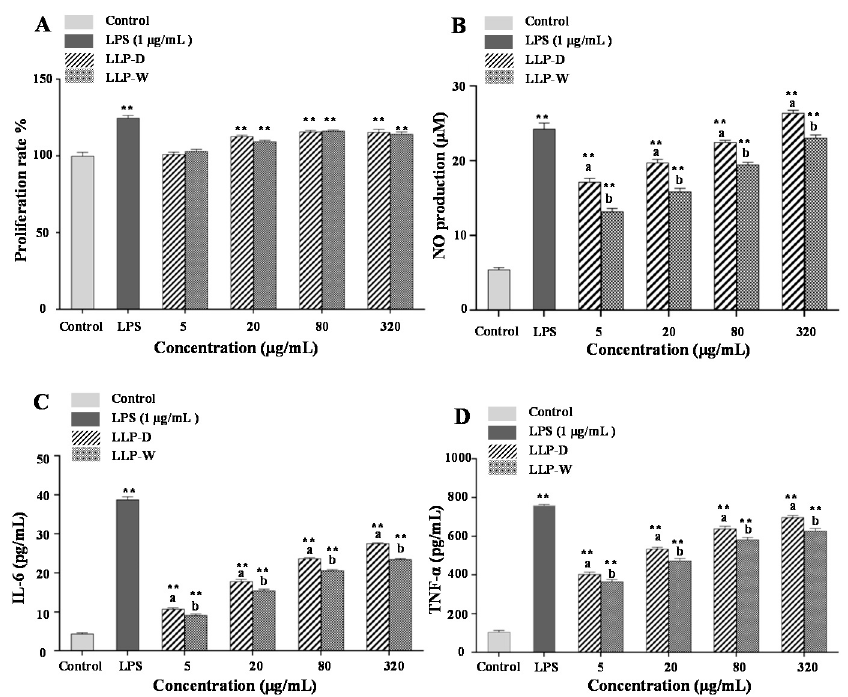
Figure 8. Effects of LLP-D and LLP-W on the cytotoxicity ( A ), NO production ( B ), IL-6 production ( C ), and TNF- α production ( D ) of RAW 264.7 macrophages. LLP-D and LLP-W are polysaccharides from lotus leaves extracted by deep eutectic solvent and hot water, respectively; Each experiment was operated in triplicate, and the error bars are standard deviations; Significant differences of cell viability and productions of NO, IL-6, and TNF- α of LLP-W and LLP-D vs. control are shown by ** p < 0.01. Superscripts a-b differ significantly ( p < 0.05) between LLP-W and LLP-D.